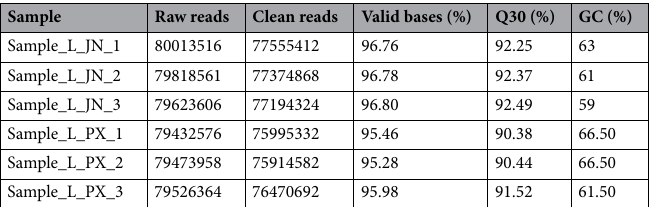
Table 2. Summary of reads of Laiwu Pig transcriptome. L_JN_1-3 refers to intramuscular adipose tissues; L_PX_1- 3 refers to subcutaneous adipose